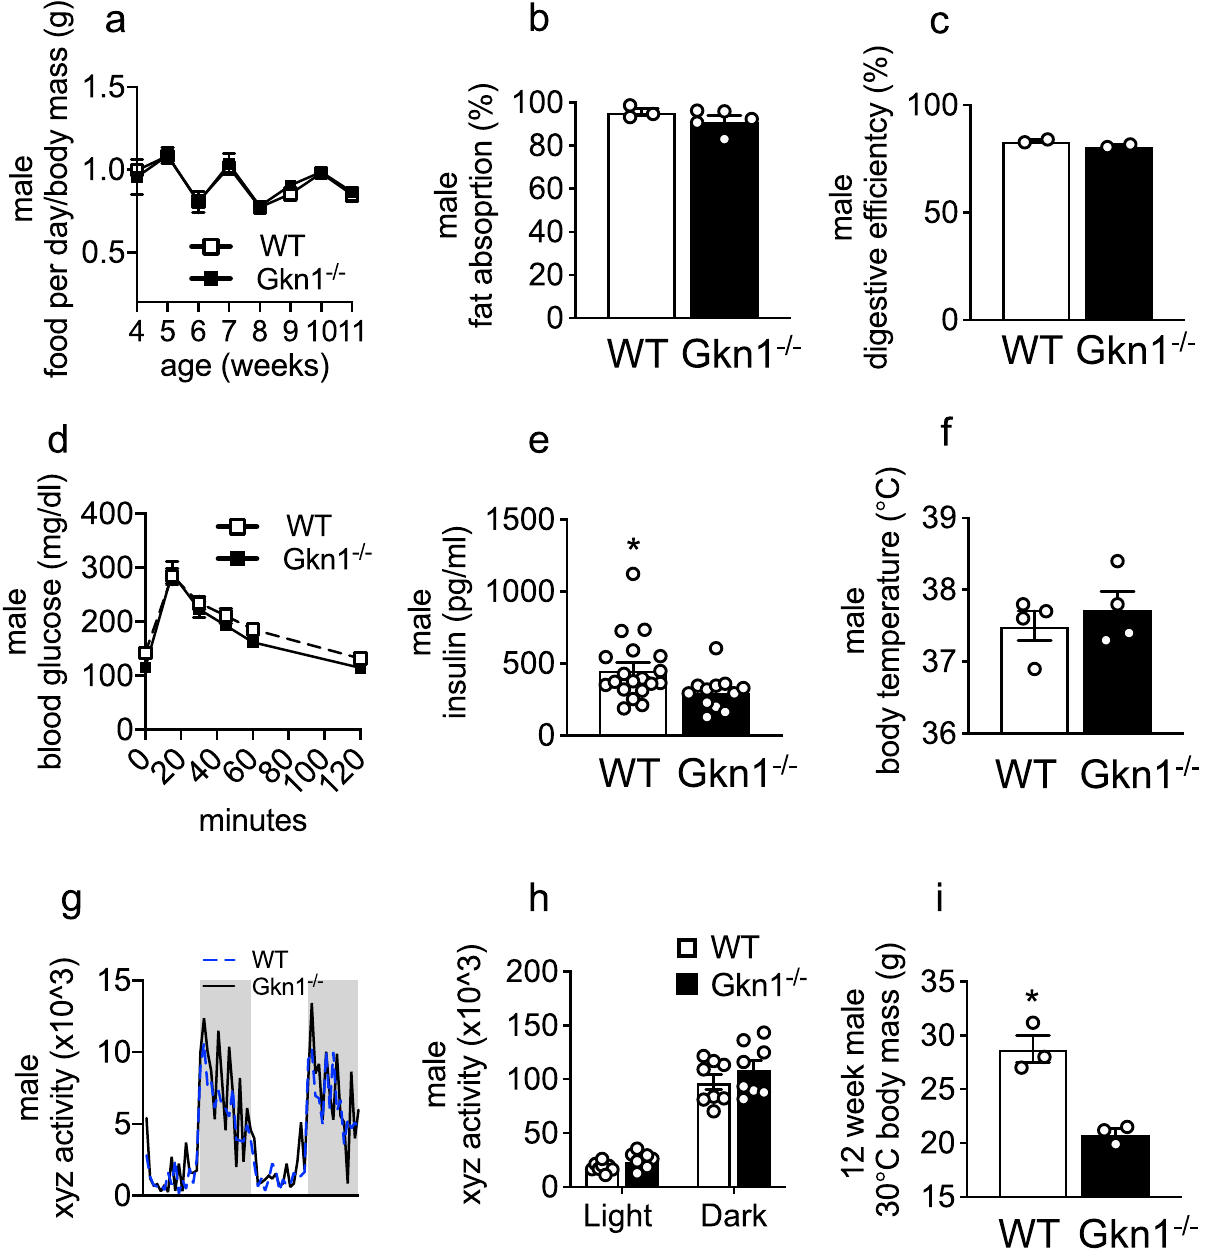
Figure 6. GKN1 −/− mice show no lean inducing phenotypes. WT and GKN1 −/− were monitored for ( a )